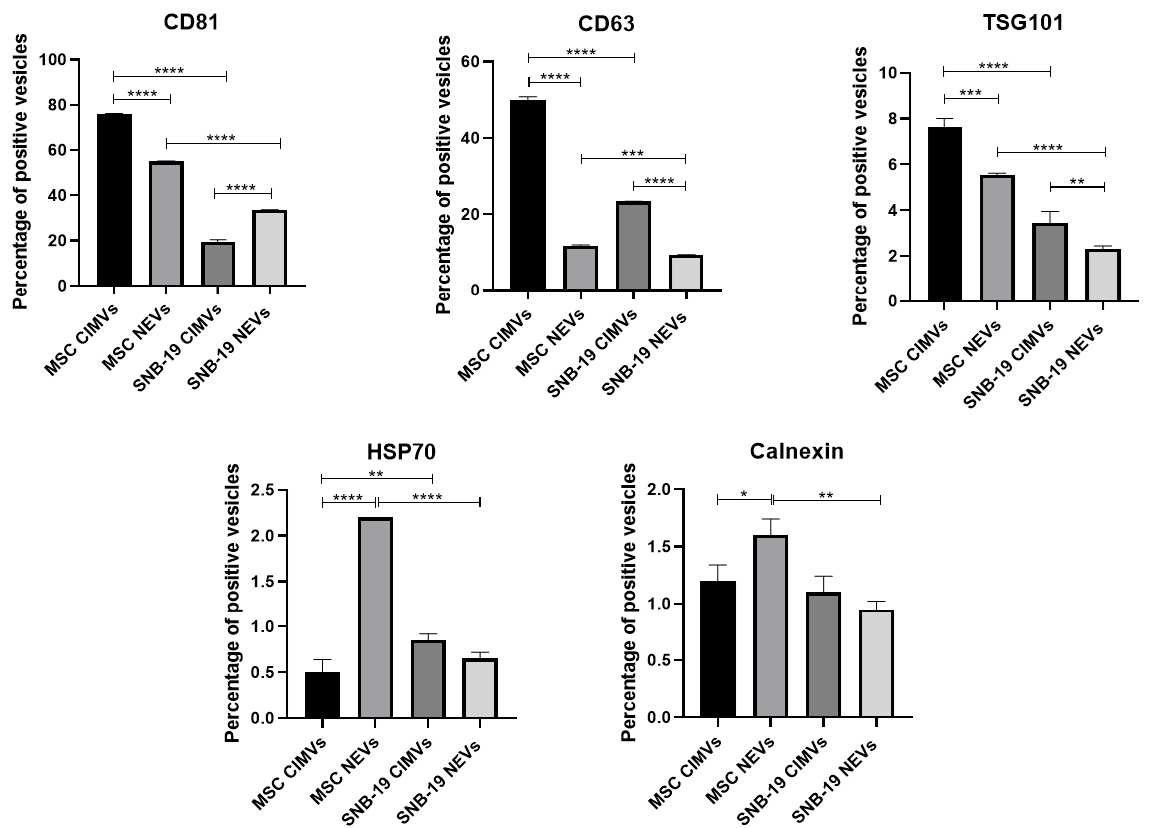
Figure 3. Morphology and size of CIMVs and NEVs isolated from MCSs and SNB-19. The data were obtained using scanning electron microscopy, scale: 1 µm, magnification: ×10.00k. Data are shown as the mean ± SD ( n = 10) of two biological replicates.